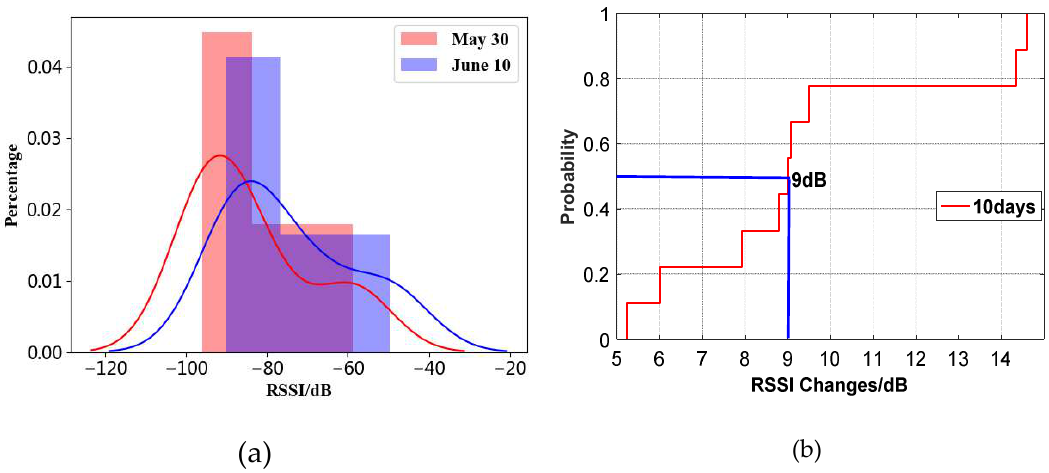
Figure 2. The dynamic fluctuation of Wi-Fi signal with time in a teaching building. ( a ) RSSI data distribution of different Wi-Fi signals at different times in a specific location. (b) RSSI changes of different Wi-Fi signals over a 10-day period in a specific location.